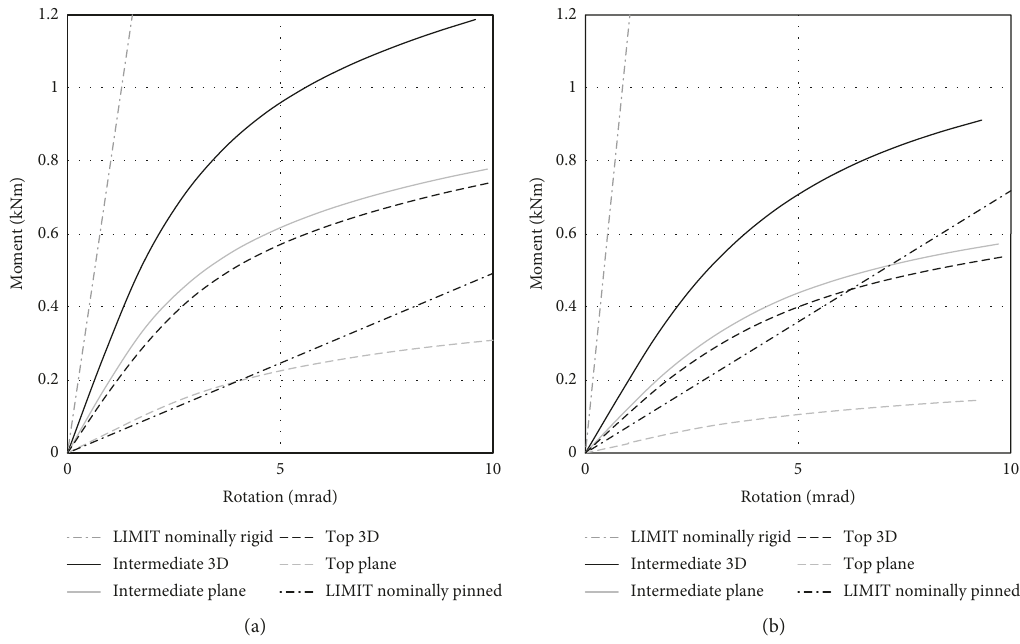
Figure 21: Moment-rotation curves for 3D and plane joints. Wall thickness (a) t